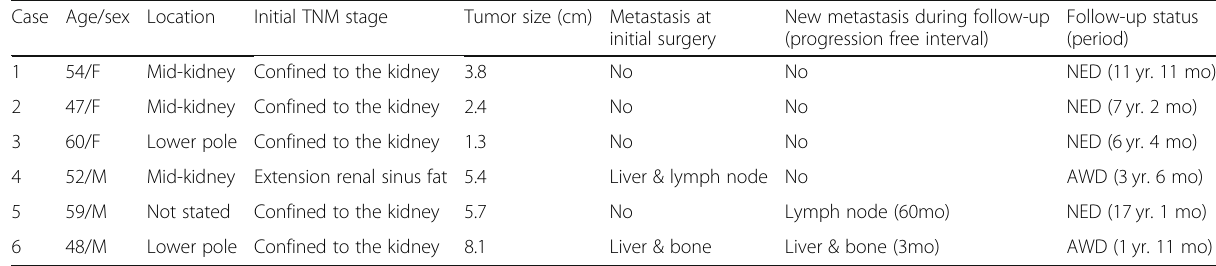
Table 1 Clinicopathologic characteristics of primary renal well-differentiated neuroendocrine tumors Case Age/sex